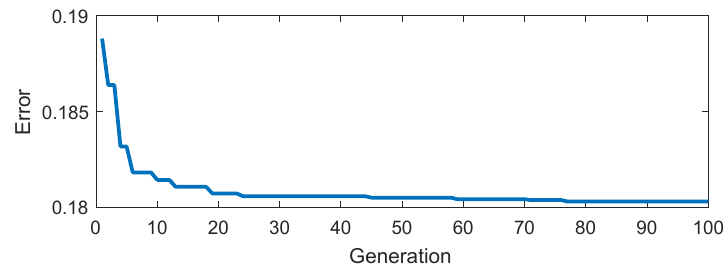
Figure 9. Objective function value (error) evolution during the tuning